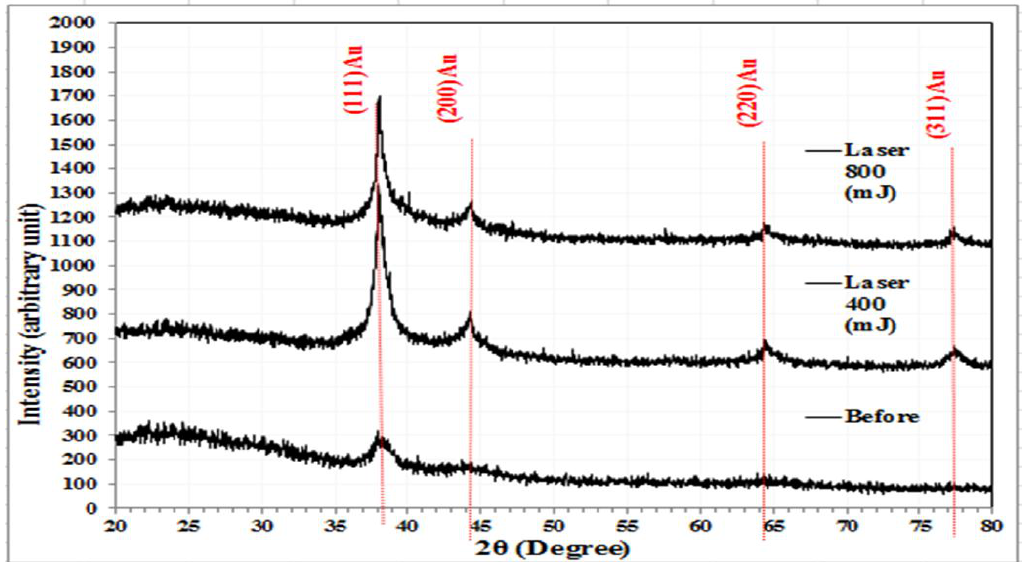
Fig. 13: X-ray diffraction pattern of C-alloy colloid NPs for exploding currents 160A and synthesized by (400m J, 800m J) laserenergies